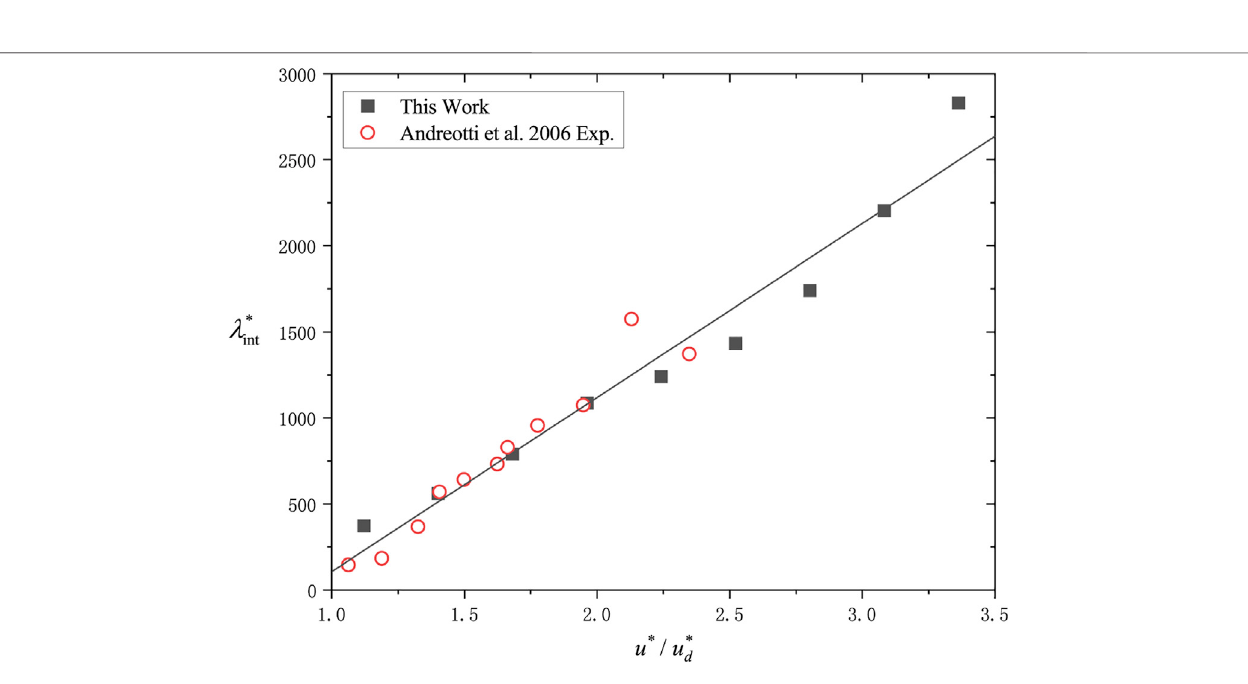
Frontiers in Physics |